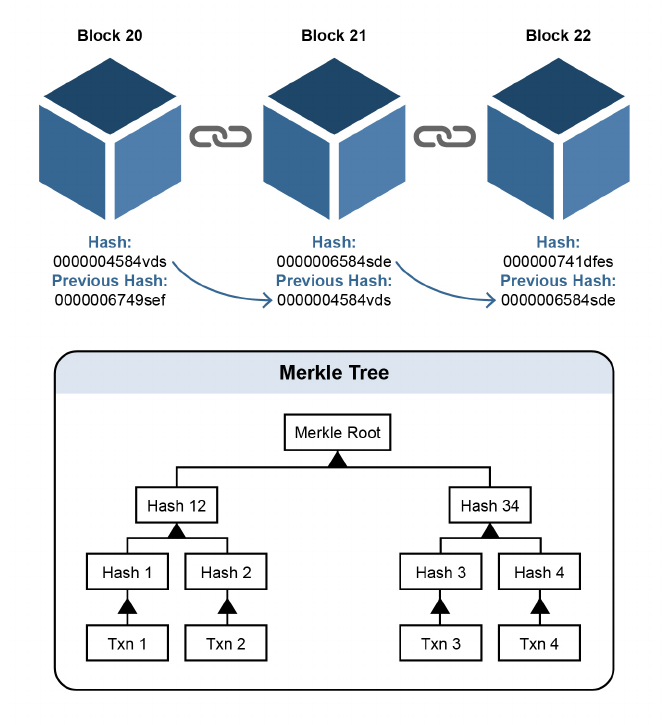
Figure 5. Blocks forming blockchain using hash